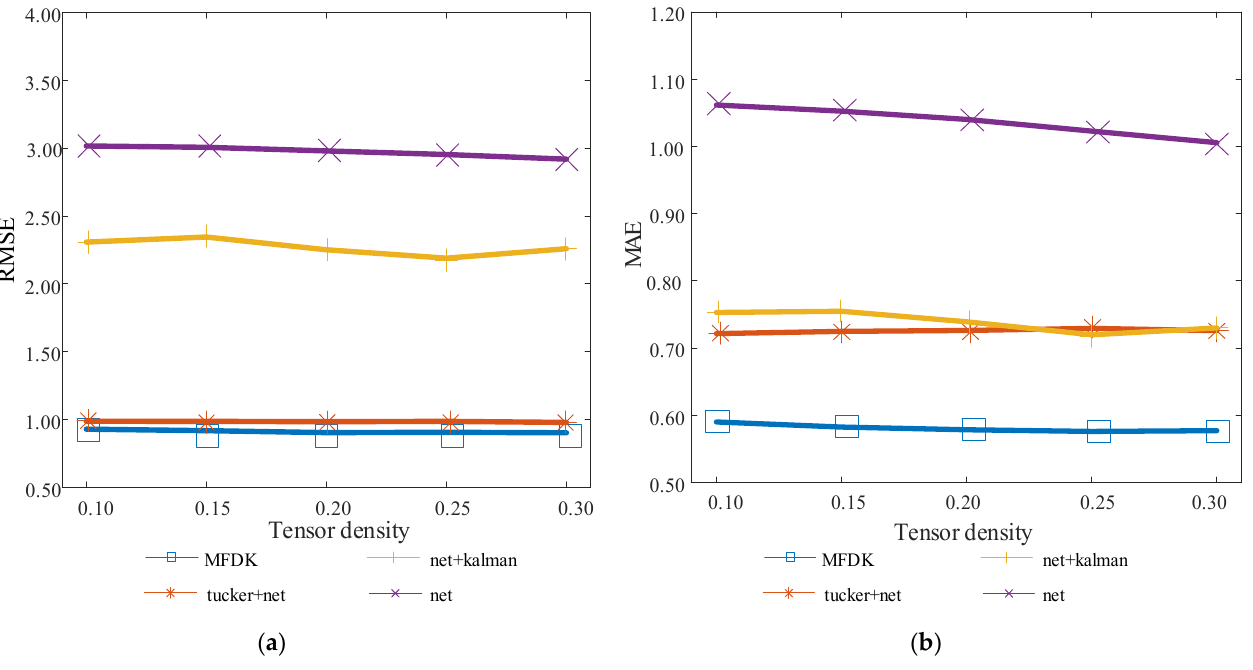
Figure 8. Results of model ablation experiments. ( a ) Variation of RMSE at different tensor densities in the ablation experiment; ( b ) variation of MAE at different tensor densities in the ablation experiment.